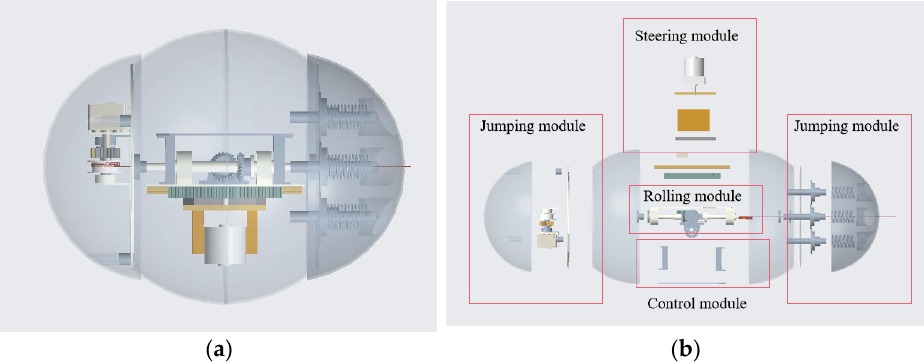
Figure 1. ( a ) The structure diagram of the rolling and jumping robot; ( b ) The exploded view of the rolling and jumping robot.